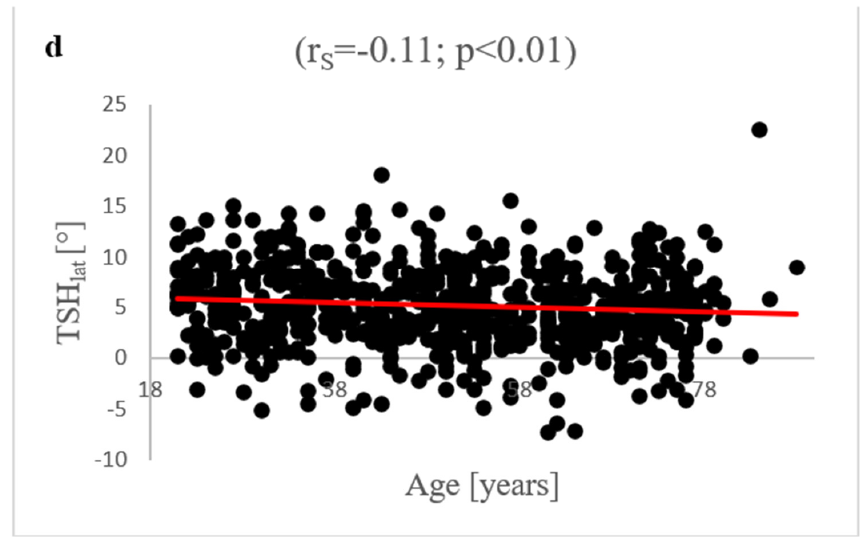
Figure 3. Correlation analysis between patients’ age and TSKmed, TSKlat, TSHmed and TSHlat: There was no significant Spearman correlation between TSKmed ( a )/TSKlat ( b ) and patient age (TSKmed: r S = 0.05; p = 0.15; TSKlat: r S = 0.02; p = 0.63). The analysis detected a significant correlation of TSHmed ( c ) and TSHlat ( d ) with patient age. A r S of − 0.1 ( p = 0.01) was found in the case of